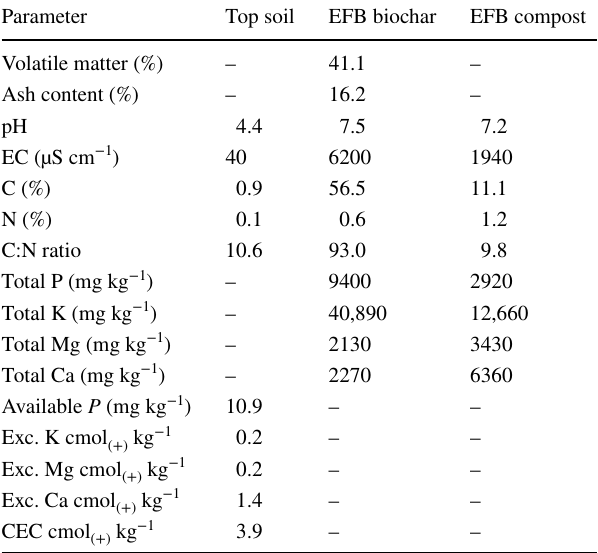
Table 3 Fertiliser programme for oil palm seedlings at main